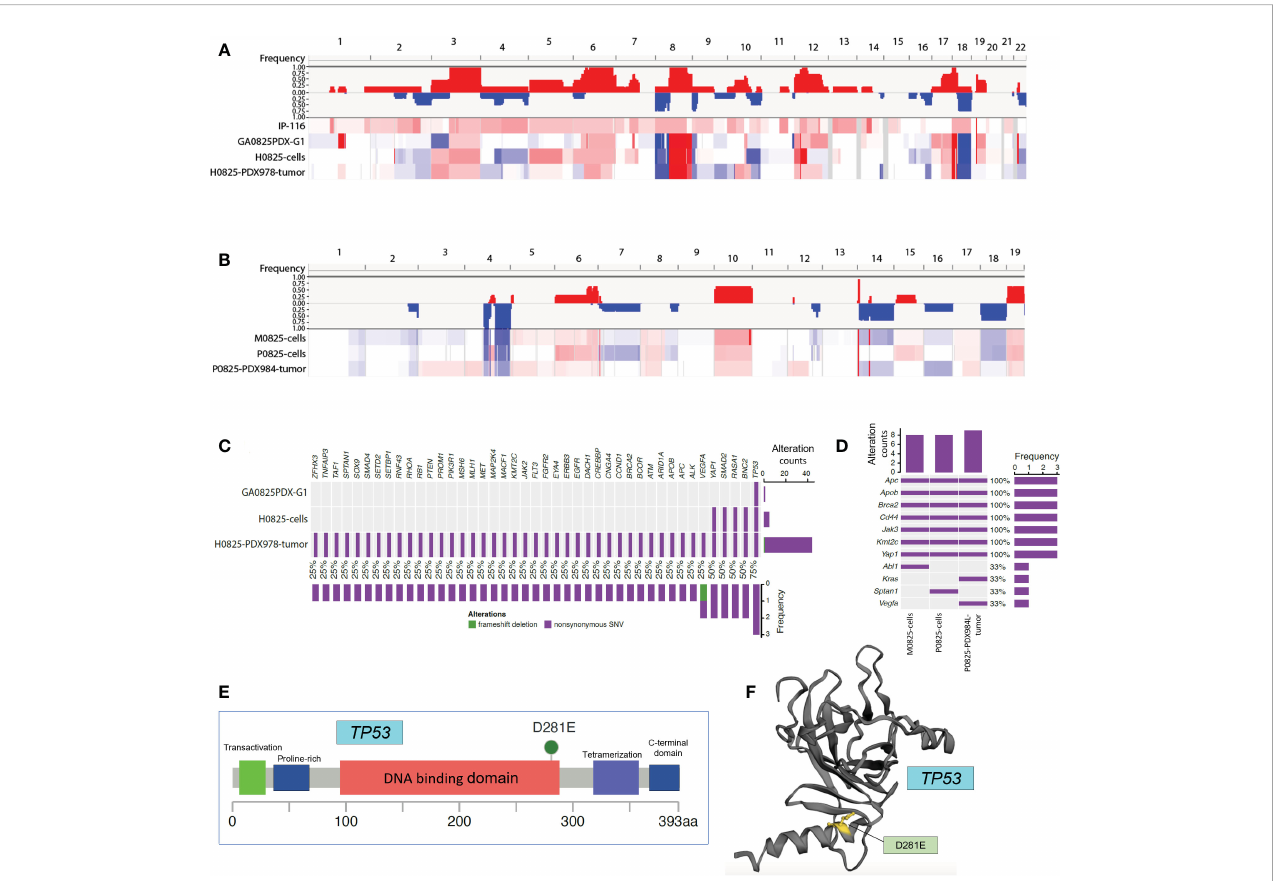
FIGURE 8 Whole exome sequencing (WES) analyses in patient ascites IP-116 and GA082517-PDX-derived human and murine samples. (A) Copy number variation (CNV) pro fi ling for human lineage IP-116, GA0825PDX-G1 tumor, H0825 cells, and H0825-PDX978 tumor, with gains in red and losses in blue. (B) CNV pro fi ling for murine lineage M0825 cells, P0825 cells, and P0825-PDX984L tumor. (C) Genomic mutations identi fi ed in human lineage GA0825PDX-G1, H0825 cells, and H0825-PDX978-tumor. The middle panel shows genomic mutations by sample and by gene (column). The histogram on the right shows the number of alterations accumulated on 43 listed genes in each individual sample. (D) Genomic alterations identi fi ed in murine lineage M0825 cells, P0825 cells, and P0825-PDX984 tumor. (E) Missense mutation in the TP53 from GA0825PDX-G1. (F) Mutated region mapped on the 3D structure of TP53.